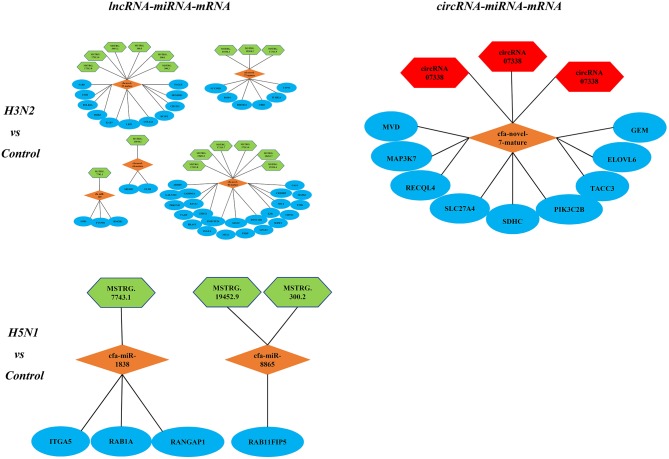
KEGG pathways associated with the lncRNA-miRNA-mRNA and circRNA-miRNA-mRNA regulatory networks; green represents lncRNAs, red represents circRNAs, orange represents miRNAs, and blue represents mRNAs.